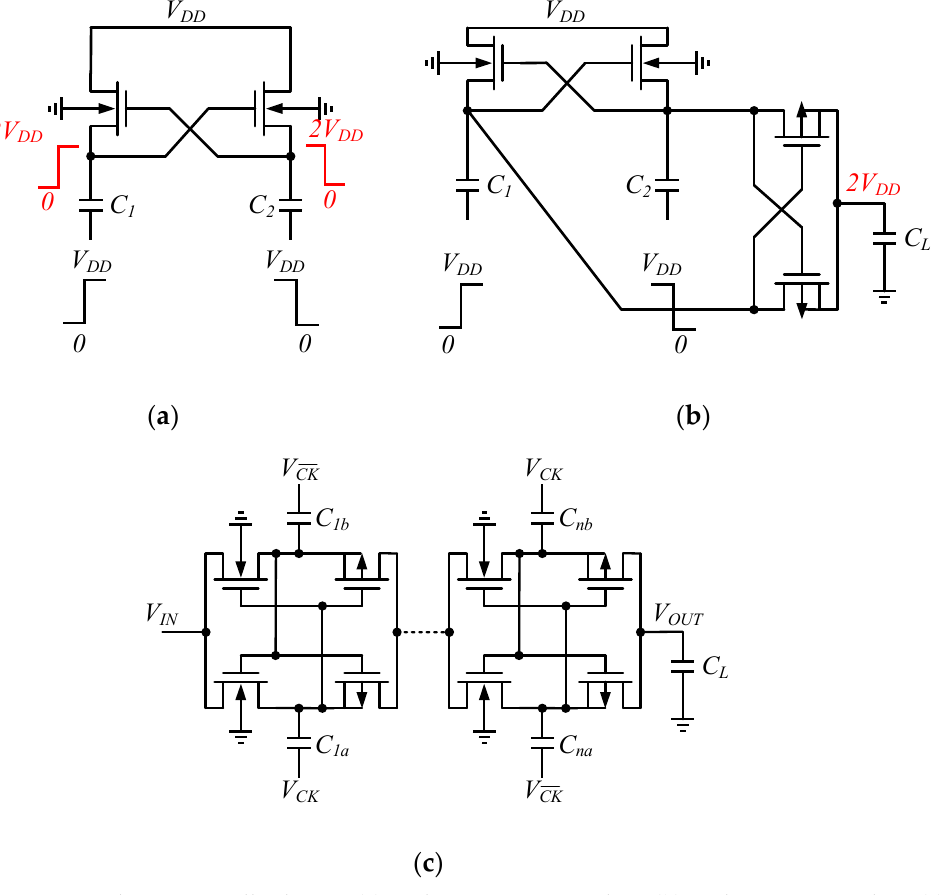
Figure 5. Nakagome’s cell scheme: ( a ) without PMOS switches; ( b ) with PMOS switches; ( c ) a cross-coupled charge pump.